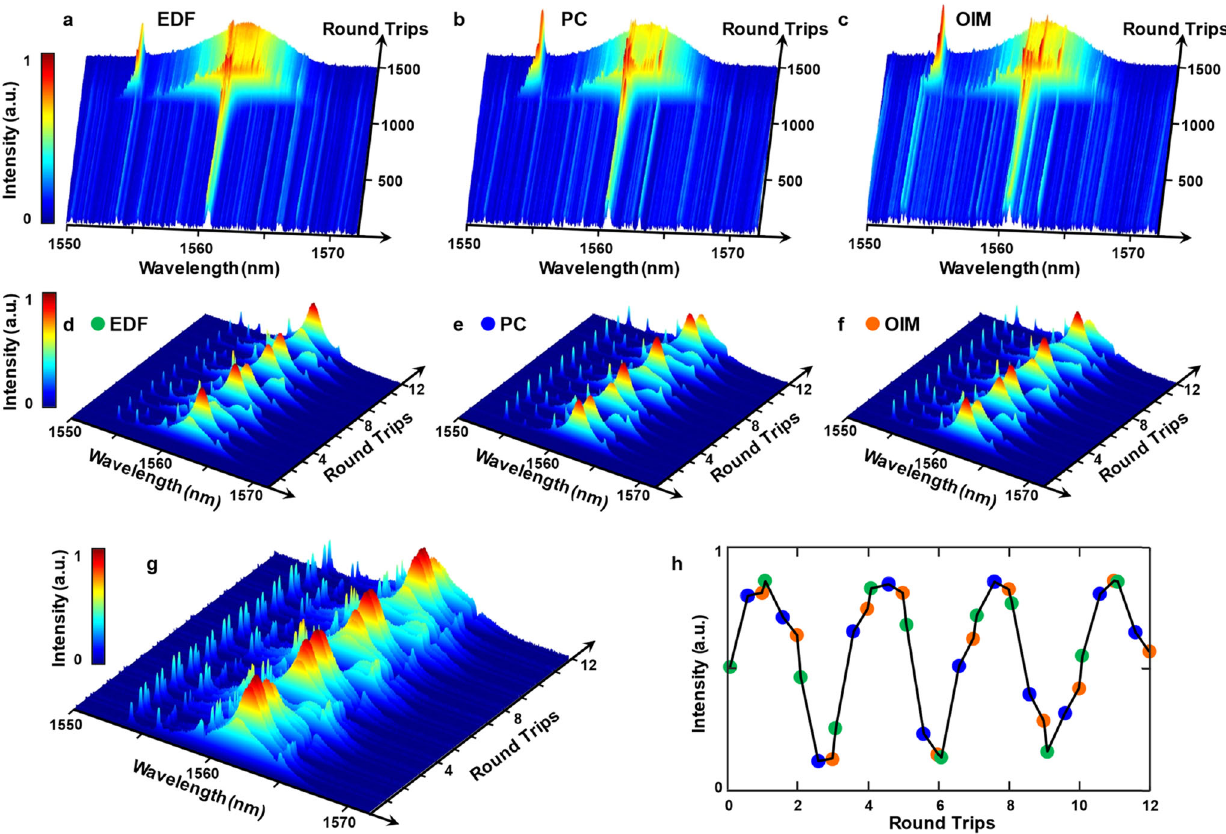
Fig. 4 The soliton dynamics of different ports. a – c are the output of the EDF, PC, and OIM ports in the initial stage respectively. Sub-pulses have a cyclical evolution in the cavity, which is asynchronous with the soliton. EDF erbium-doped fi ber, PC polarization controller, OIM optical integrated module. d – f are 12 consecutive spectra in the spectral beating phase for the EDF port, PC port, and OIM port respectively. The spectral beating process is obvious but irregular and soliton in different ports are at different beating states. g The reconstituted spectra show a regular beating process and many other details. h The intensity evolution process at the central wavelength position, is approximately a sinusoidal evolution process with a period of about 3.33 RTs. The green, blue, and orange dots represent the outputs of the EDF, PC, and OIM ports,